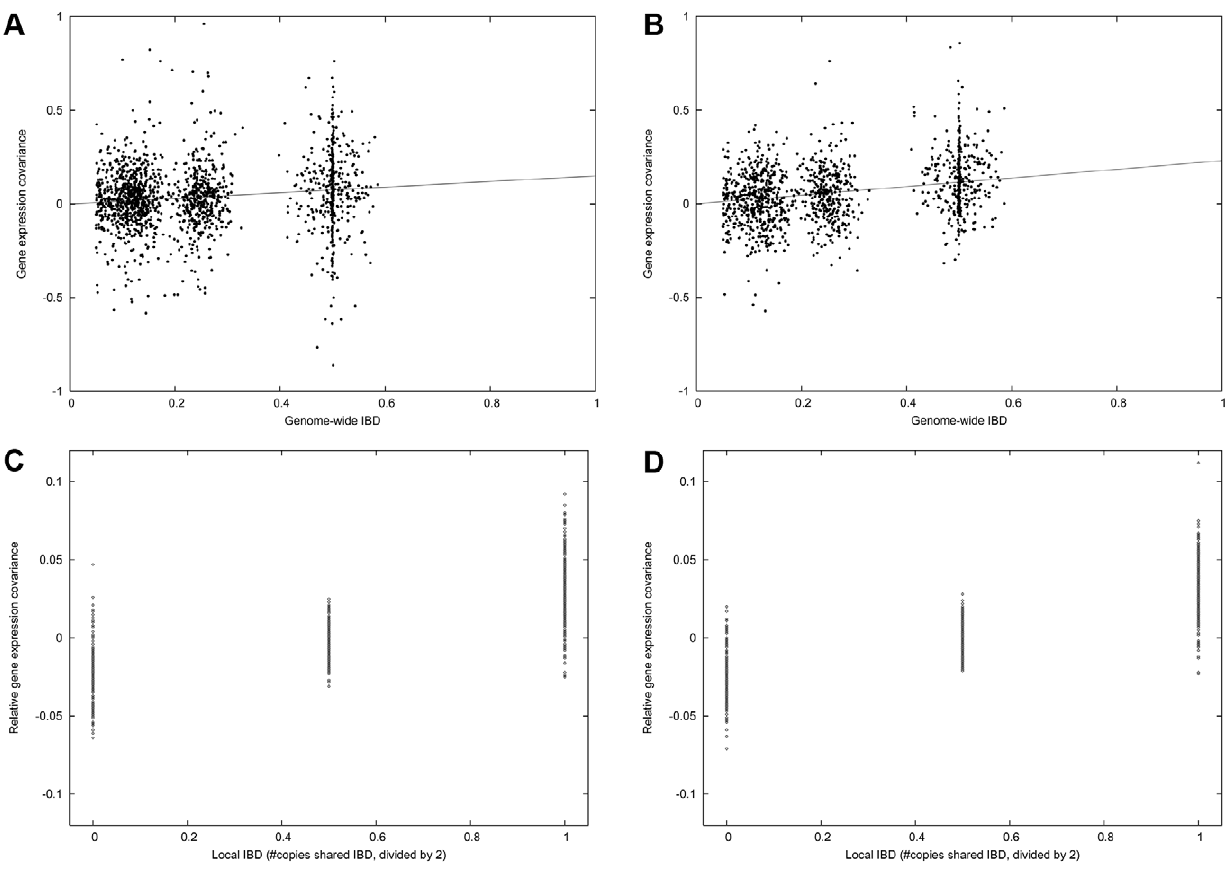
Figure 2. Family heritability in the IFB and IFA cohorts. (A) Gene expression covariance (average value of product of normalized gene expression measurements) between related individuals in the IFB cohort varies with genome-wide IBD. Each point represents one pair of related individuals. The slope of this plot corresponds to the regression-based estimate of h 2 . (B) Same as (A), for IFA cohort. (C) Gene expression covariance between siblings for genes with 0, 1 or 2 copies IBD at the cis locus, minus total covariance as displayed above. The slope of this plot corresponds to the regression-based estimate of h cis 2 . The signal to noise ratio is higher in this plot due to reduced effects of systematic noise covariance. (D) Same as (C), for IFA cohort.